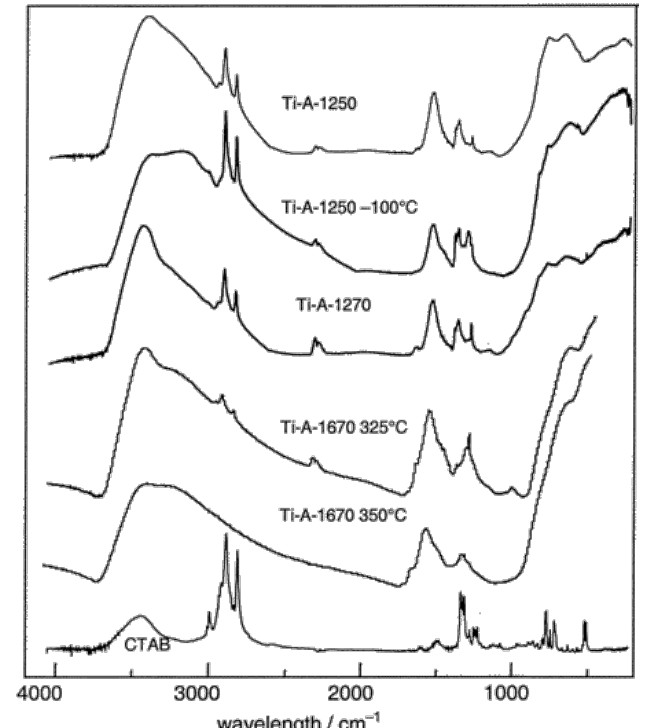
hybrid solids prepared using 2